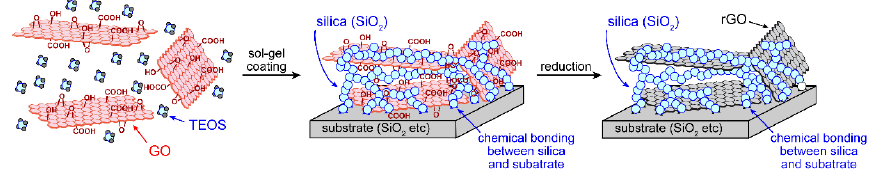
Figure 14. Conceptual diagram of the synthesis of rGO/silica composite films using sol–gel reaction. Table 1. Feed ratio of GO and TEOS and the theoretical content of silica in the resulting films. Films